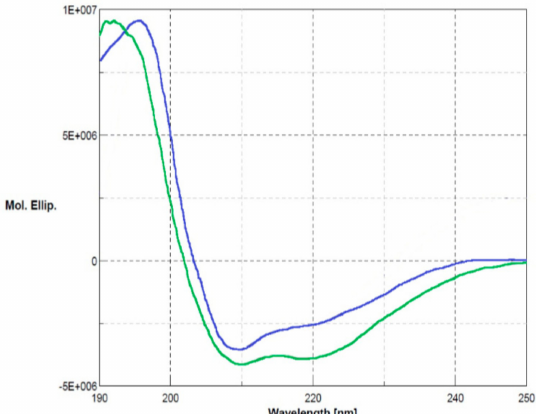
Figure 2. Circular dichroism analyses of glutathione S-transferase (GST)-Ogt fused protein (blue line) in comparison with native GST (green line). Secondary structures: α -helix 3 × 10 − 1 , β -sheets 2.2 × 10 − 1 and turn 1.2 × 10 − 1